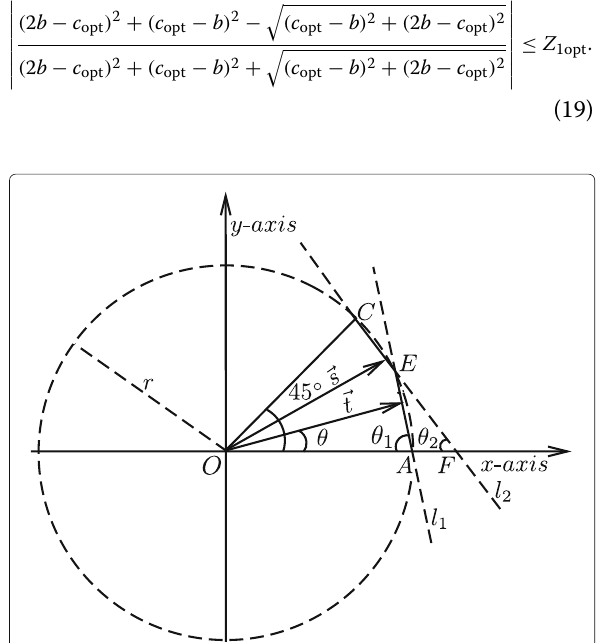
Fig. 4 Octant portion of the chamfer polygon generated by a 5 × 5 mask. Lines that overlap the polygon’s sides are defined by l 1 : ( c − 2 a ) y + ax = r and l 2 : ( 2 b − c ) y + ( c − b ) x = r . Critical corner points are A Euclidean local neighborhood, a = 1, b =